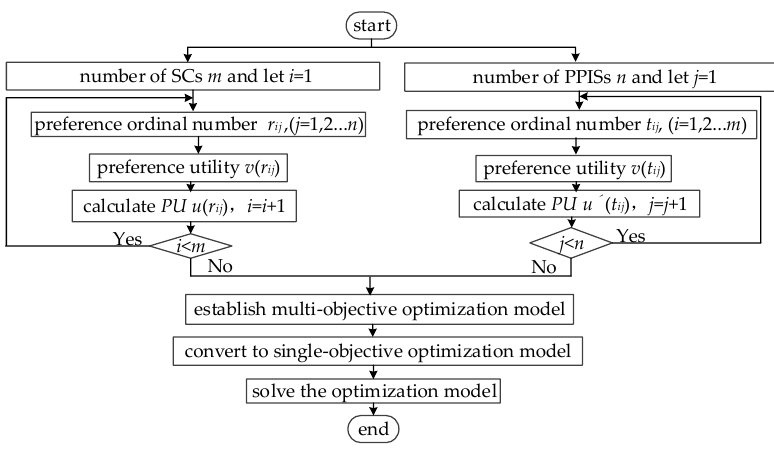
Figure 5. Matching process between SCs’ and the premium power level.